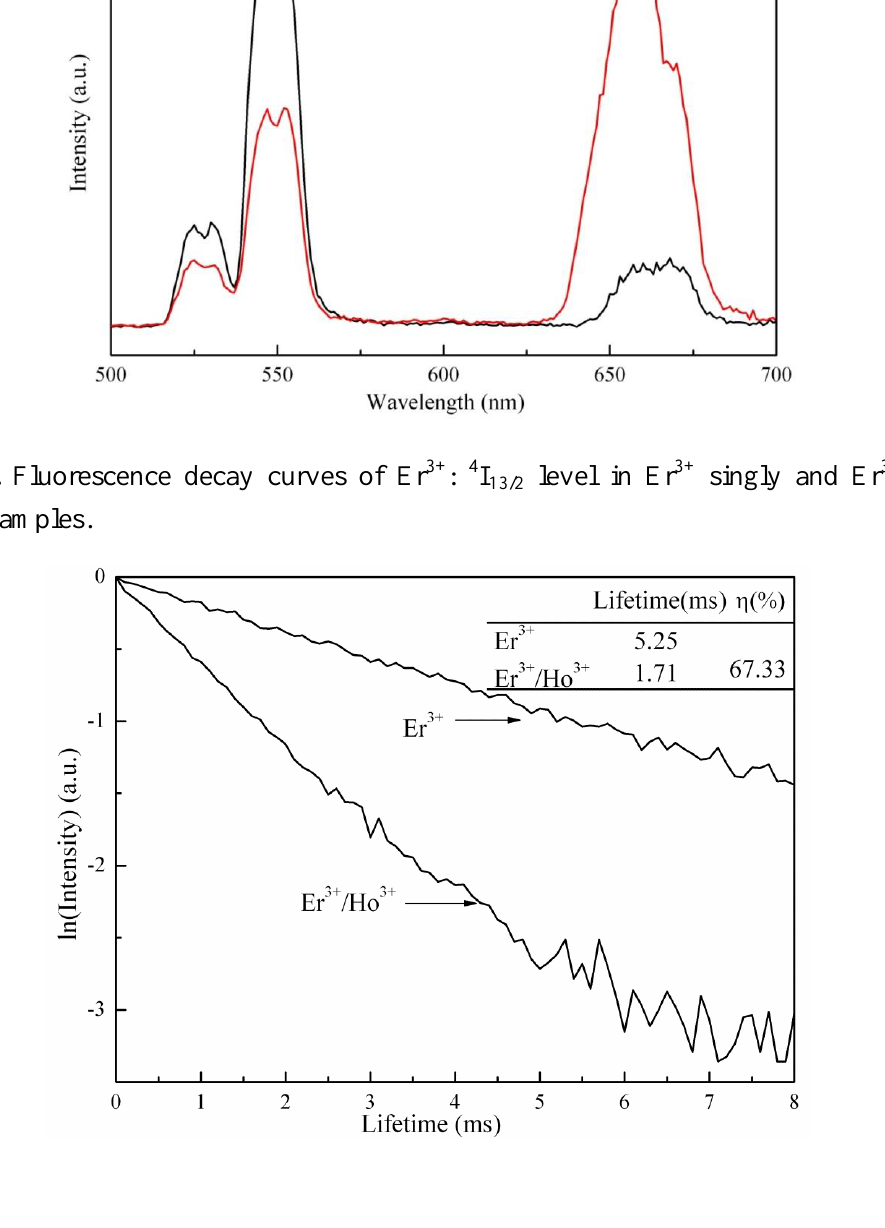
Figure 4. Upconversion emission spectra of Er 3+ and Er 3+ /Ho 3+ -codoped glass samples.